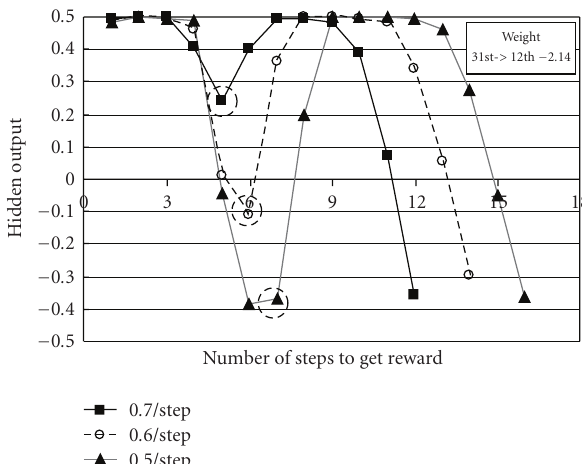
Figure 11: Change in output of the 31st hidden neuron for the three velocities. Broken circles indicate the timing just before the object disappears. Important connection weight value from this neuron is given in a box. In this case, the connection weight from the 31st neuron to the 12th neuron is − 2 . 14.